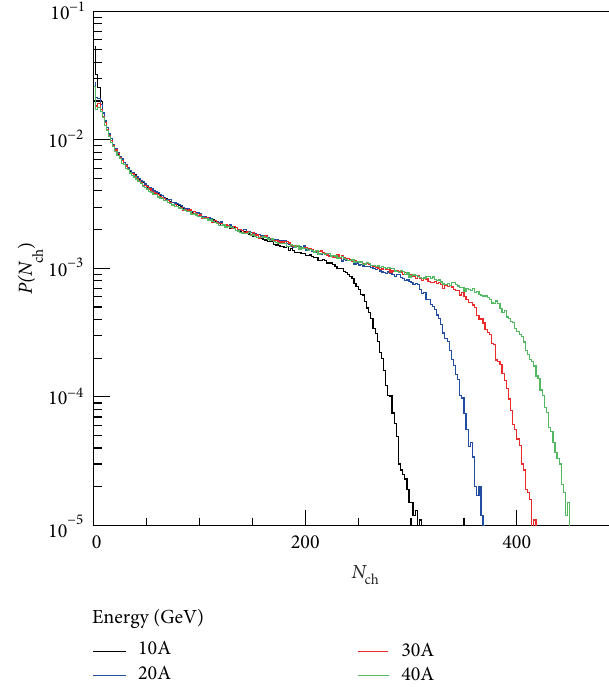
Figure 4: Multiplicity distributions of charged particles for AuAu collisions at 10A, 20A, 30A, and 40A GeV in the range 󵄨󵄨󵄨󵄨𝜂󵄨󵄨󵄨󵄨 𝑝 𝑇 = 0.2 − 5.0 GeV/c and = 1.0 .